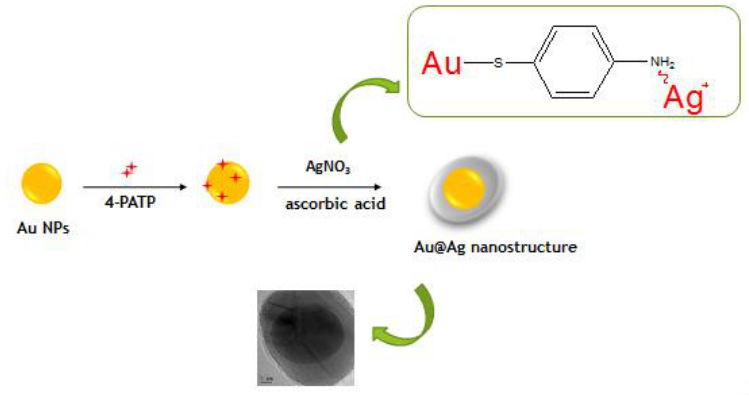
Figure 1. Synthesis of Au@Ag nanostructures containing an internal Raman standard.